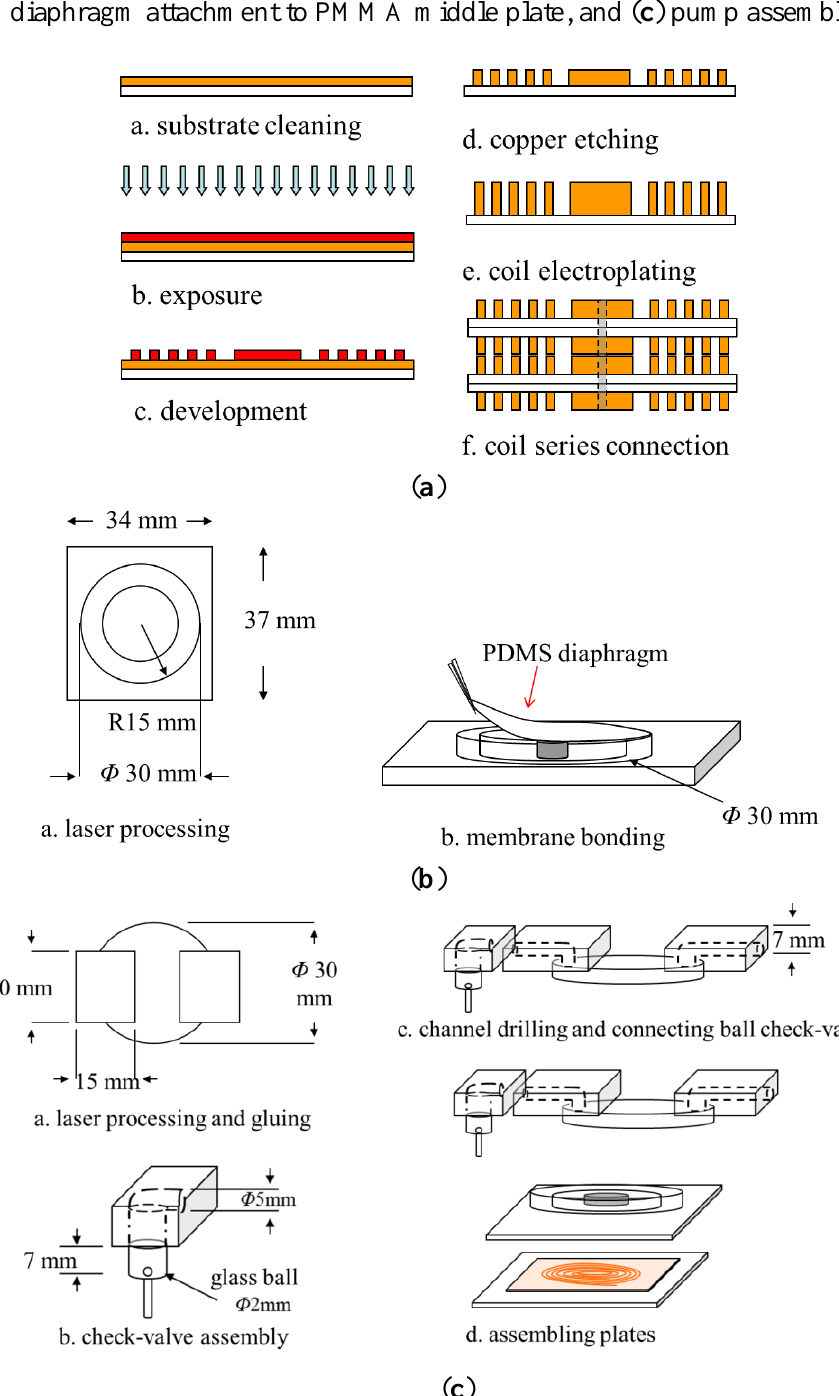
Figure 2. Major steps in pump fabrication process: ( a ) microcoil patterning and deposition, ( b ) PDMS diaphragm attachment to PMMA middle plate, and ( c ) pump